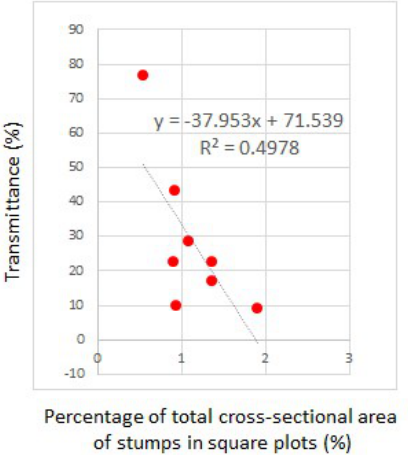
Figure 17 . Relationship between LiDAR transmittance and total cross-sectional area in granite site (Onigajo and Ojiroi).